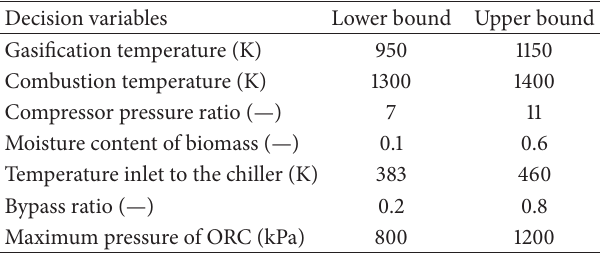
Table 5: Reasonable range of decision